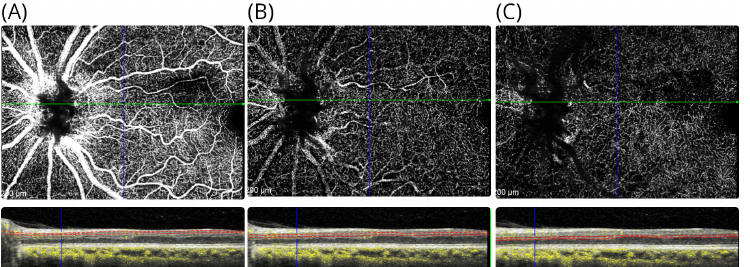
Figure 6. OCTA in patient #2. The OCTA shows the ( A ) the inner retinal vasculature at level of the RNFL, ( B ) the superficial vascular plexus above the INL, and ( C ) the deep vascular plexus located below the INL. For each OCTA, the layer segmentation (red dashed lines) and OCTA signal (yellow) are